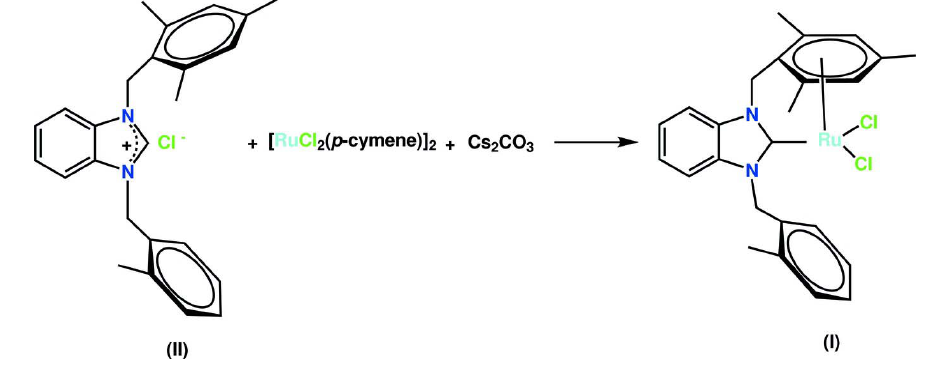
Figure 3 Synthesis of Ru(NHC)